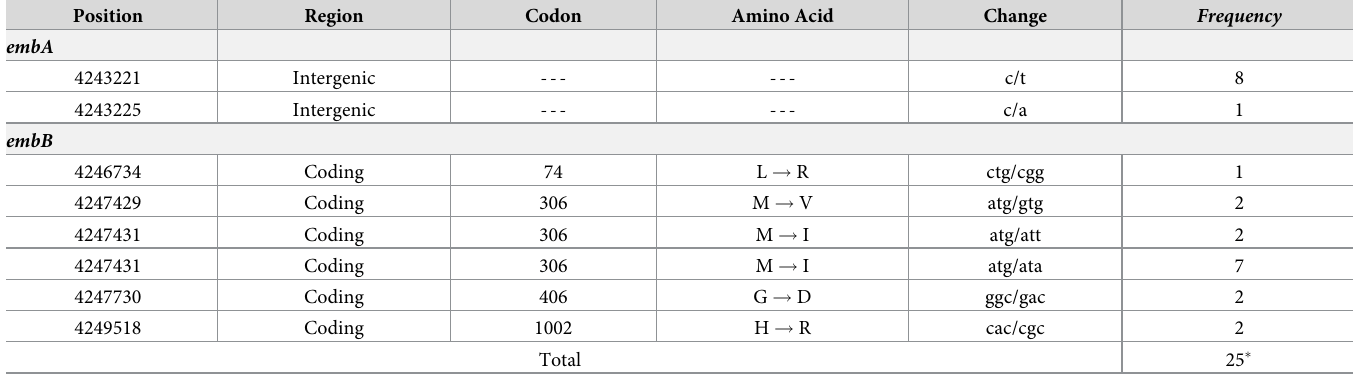
Table 3. Ethambutol mutations obtained by WGS from isolates of Mycobacterium tuberculosis circulating in Veracruz, Mexico. Position Region Codon Amino Acid embA